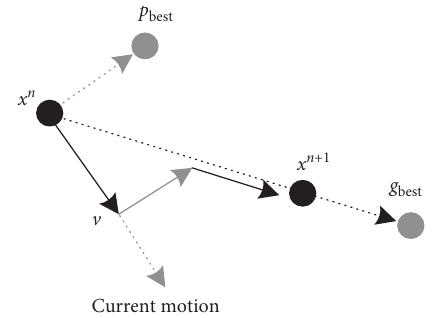
Figure 8: Movement of particles in 2D space.